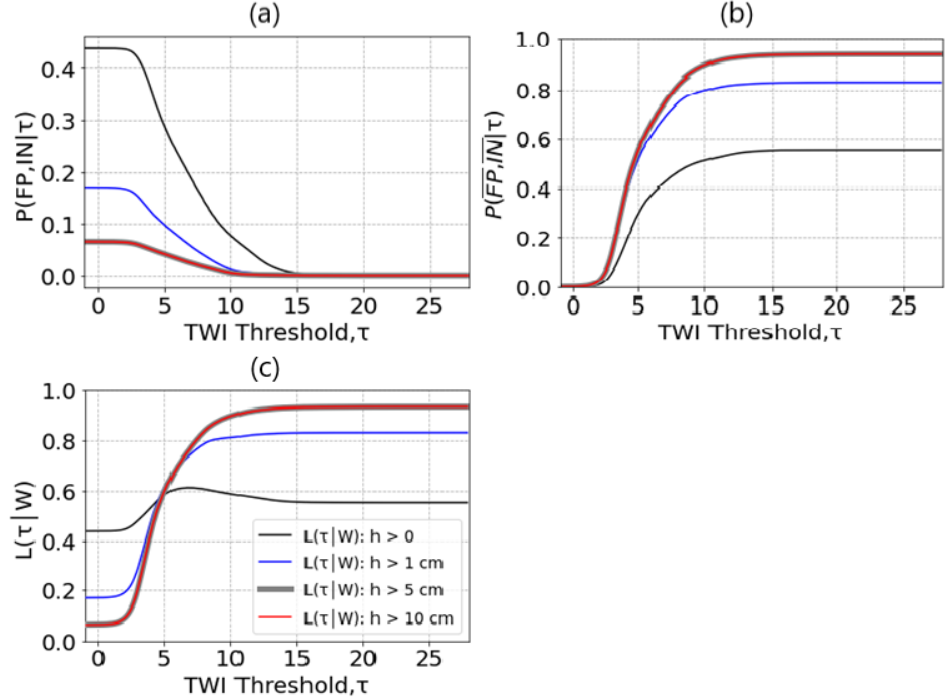
Figure 12. Probabilities of 50 mm precipitation